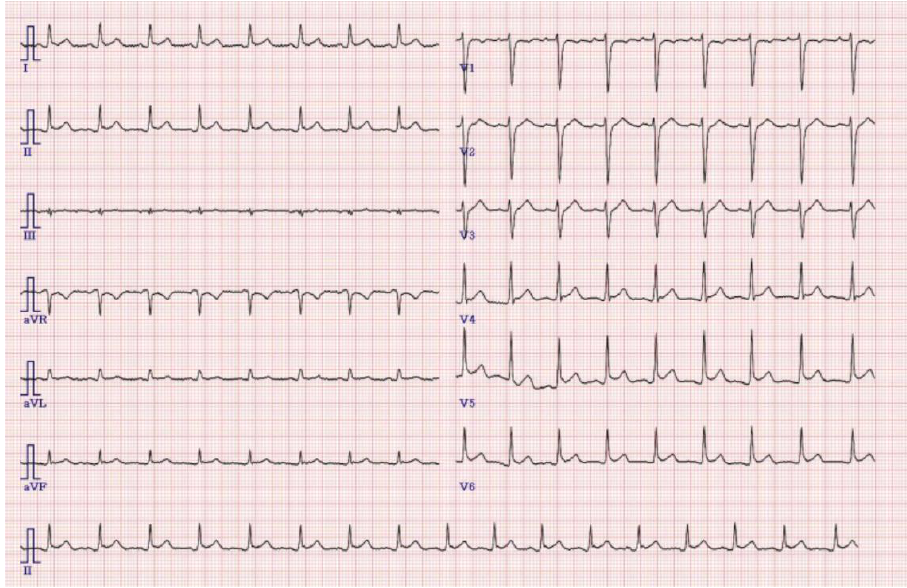
Figure 2. Sinus tachycardia was noted on the 12-lead electrocardiogram.